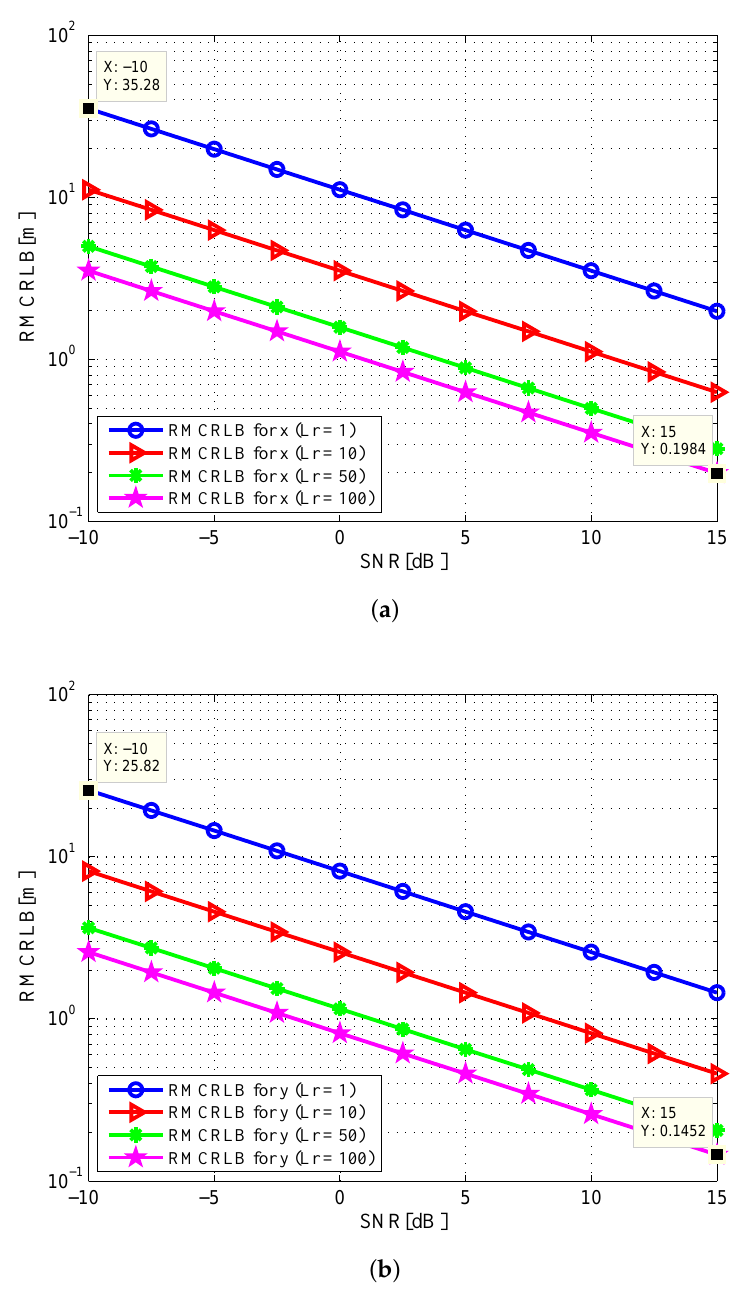
Figure 2. RMCRLB versus SNR in target position dimensions with different L r : ( a ) x-position; ( b )